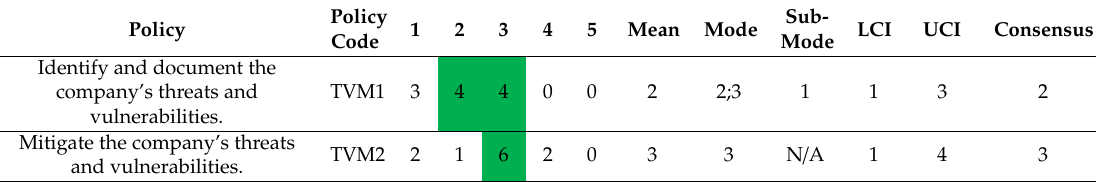
Table 11. Threat and vulnerability management policies’ starting maturity.